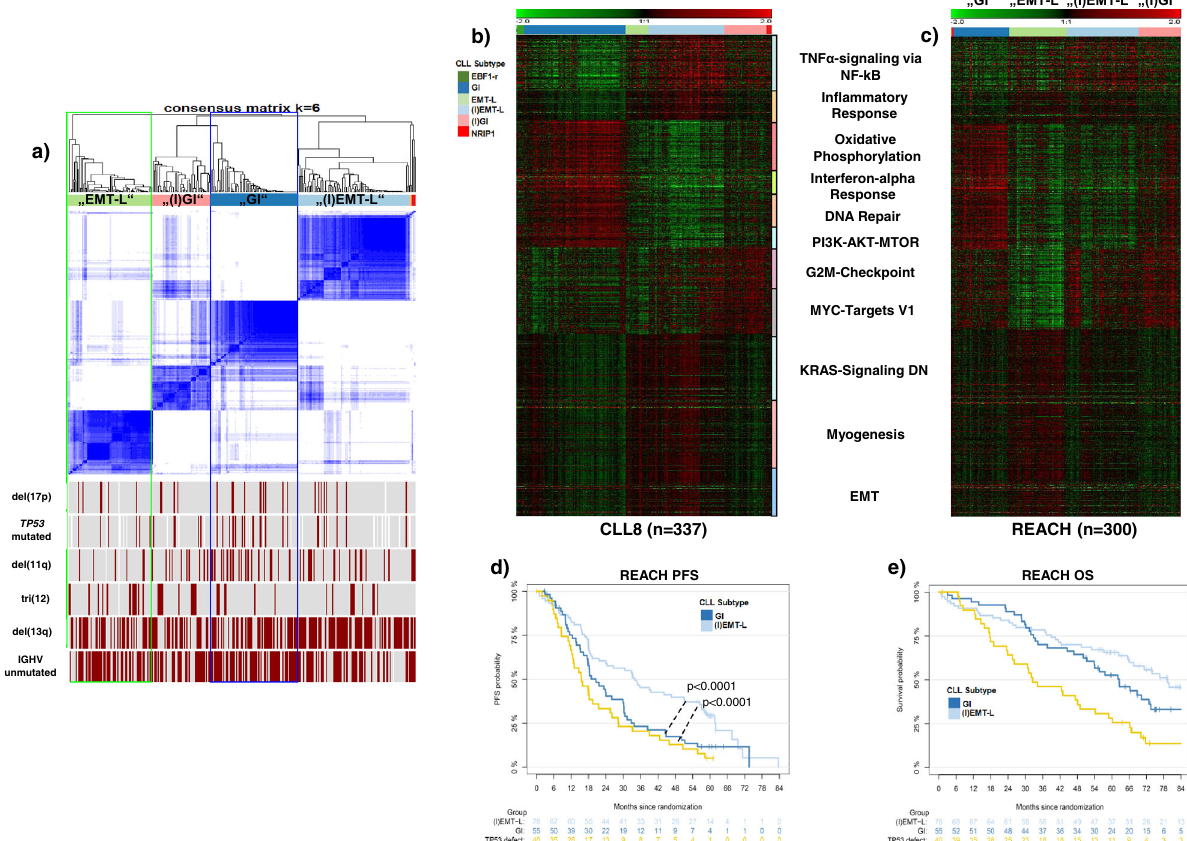
Fig. 6 Validation of CLL subtypes and prognostic impact in the REACH trial cohort. a Consensus heatmap showing the 4 major CLL subtypes identi fi ed in the REACH expression dataset ( n = 295); only a few cases ( n = 5) segregate in unde fi ned clusters (red/orange). Recurrent alterations are depicted below, inactivation (del/mut) of TP53 is heterogeneously distributed ( “ EMT-L ” : 11%, “ (I)GI ” : 16%, “ GI ” : 20%, “ (I)EMT-L ” : 9%). b Heatmap depicting characteristic GEP in CLL8 (major core enrichment gene sets, 931 genes). c Heatmap showing expression of core enrichment gene sets (as used in ( b )) for the REACH dataset. For better comparability, CLL8-complementary clusters (indicated by labels in quotation marks) are ordered in the same order as found by consensus clustering in CLL8. Increased biologic homogeneity is observed in “ GI ” / “ (I)GI ” cases and supported through co-clustering in ( a ). d PFS in the REACH dataset for all cases with TP53 defect (yellow), “ (I)EMT-L ” and “ GI ” cases without TP53 defect ( n = 173). The signi fi cance level for GI vs. (I)EMT-L cases is calculated based on clustering from ( a ). e OS in the REACH dataset for all cases with TP53 defect (yellow), “ (I)EMT-L ” and “ GI ” cases without TP53 defect ( n = 173). For d , e , the log-rank test was used to compare the survival distributions. Data within individual fi gures derives from biologically independent